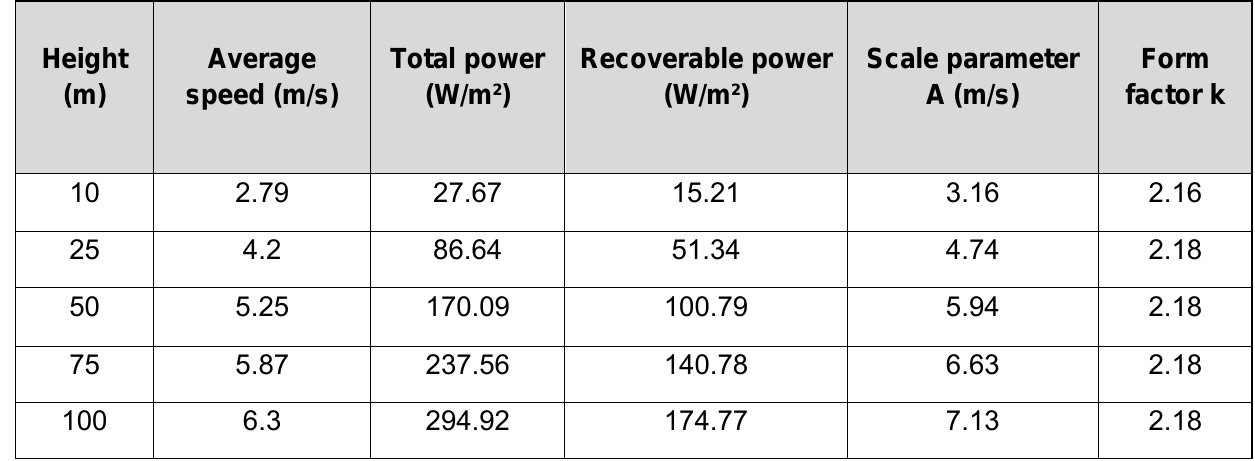
Table 2. Average values of speeds and energies at different altitudes